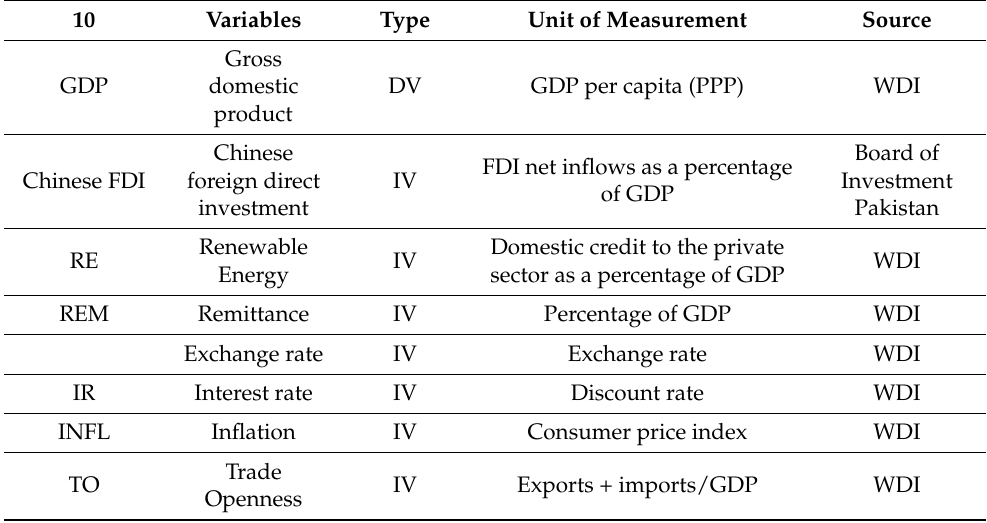
Table 1. List of